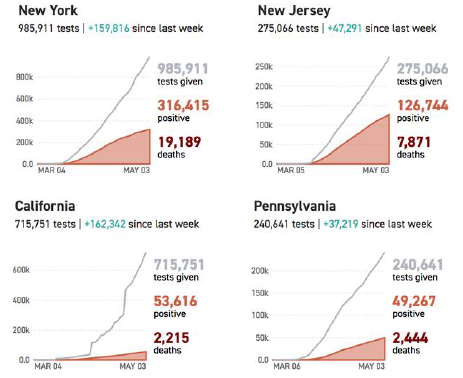
Figure 2. Corona cases graphs (Beatrice Jin